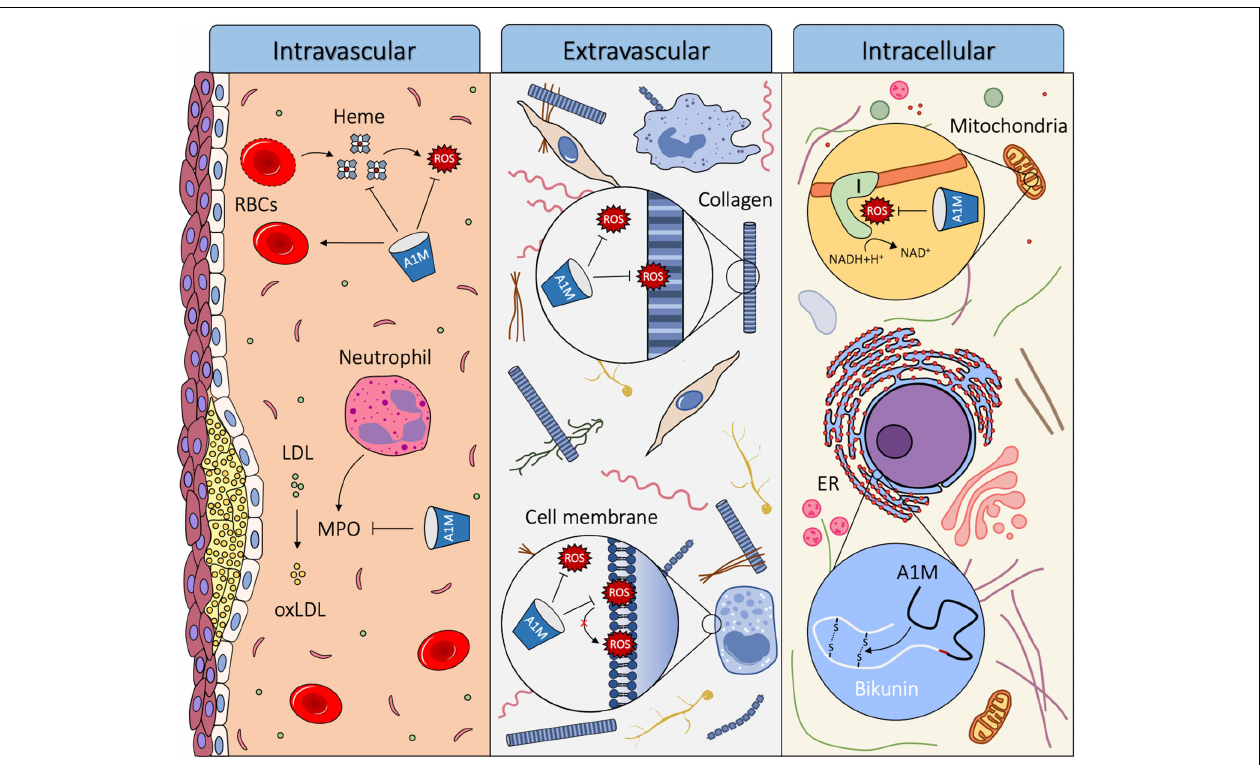
FIGURE 5 | Proposed biological roles of A1M. Using its heme binding, radical scavenging and reductase activity, A1M can act as a housekeeping protein in three different compartments of the body: intravascular, extravascular and intracellular. Intravascularly, A1M acts a stabilizer of red blood cells, it reduces damage from hemolytic events by binding heme and reducing Hb and it inhibits oxidation of LDL by MPO. Extravascularly, A1M protects tissues, cells and macromolecules from oxidative insults, including reducing oxidation products formed on ECM structures and lipid peroxidation of cell membranes. Intracellularly, A1M is bound to Complex I of the respiratory chain in the mitochondria where it may have a radical scavenging function and preserves ATP-production. A1M also acts as a chaperone during the folding of bikunin in the